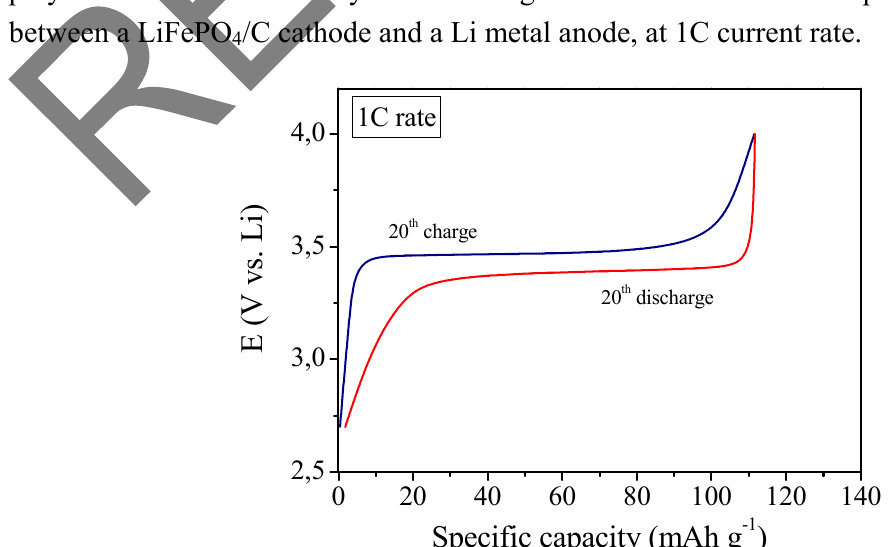
Figure 8. Ambient temperature galvanostatic charge-discharge profiles of the lithium polymer cell assembled by sandwiching the MC-PE reinforced polymer electrolyte /C cathode and a Li metal anode, at 1C current between a LiFePO 4